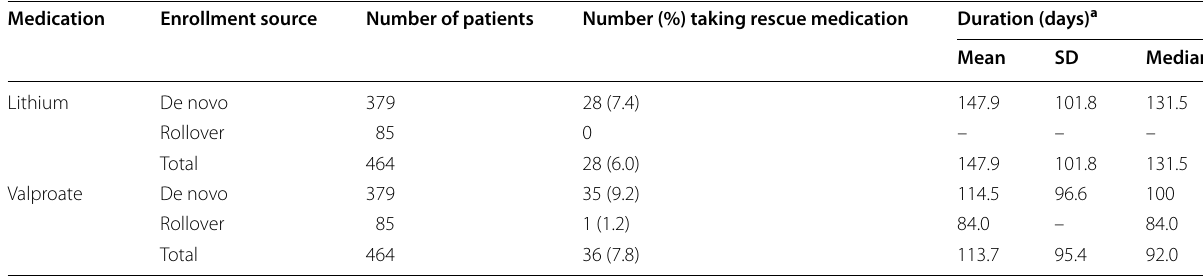
Table 3 Rescue medication use during the AOM 400 maintenance